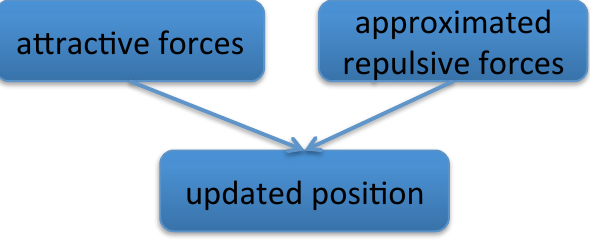
Figure 4. The GPU computation flowchart for a single level graph layout. The kernels of attractive forces and approximated repulsive forces are described in Algorithms 1 and